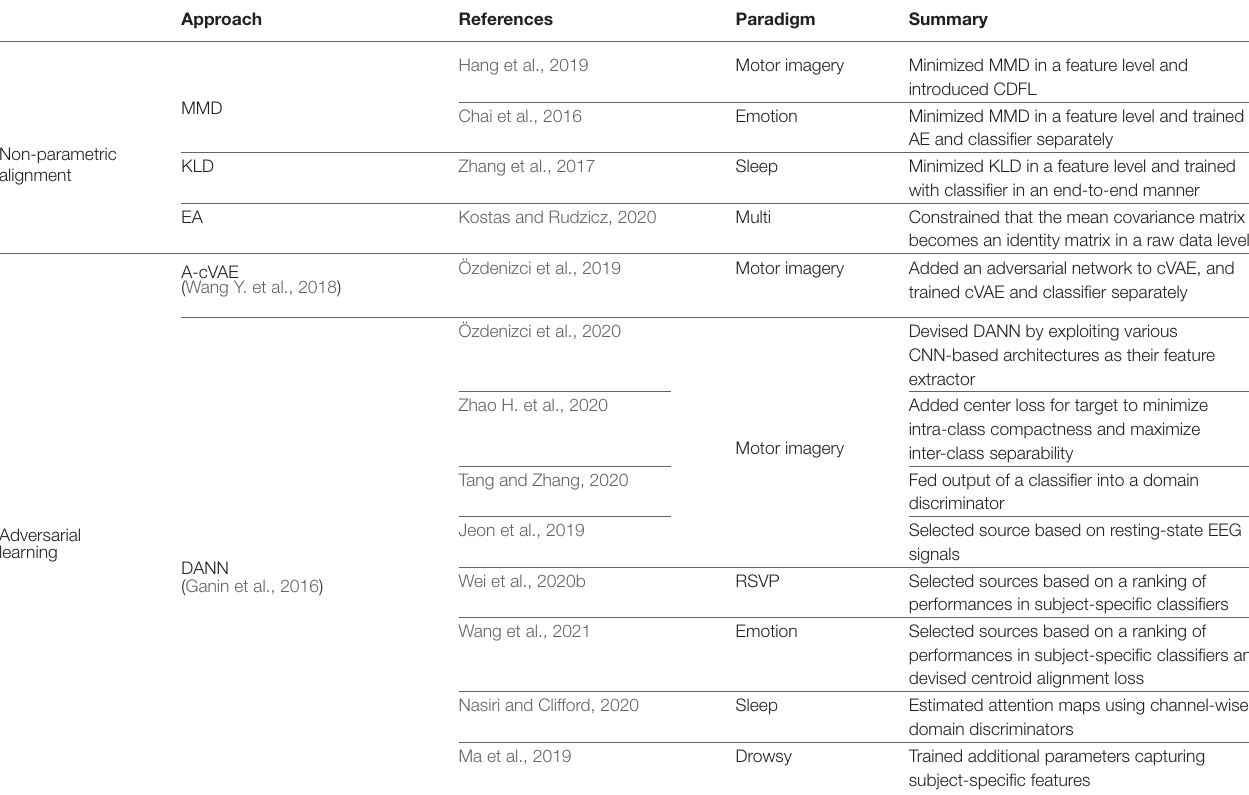
TABLE 3 | Explicit transfer learning